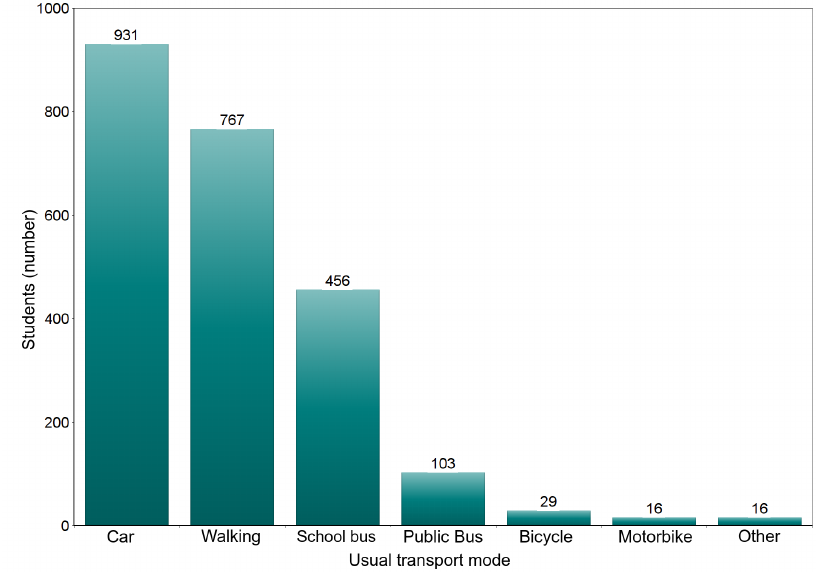
Figure 3. Most common means of transport on home–school routes.